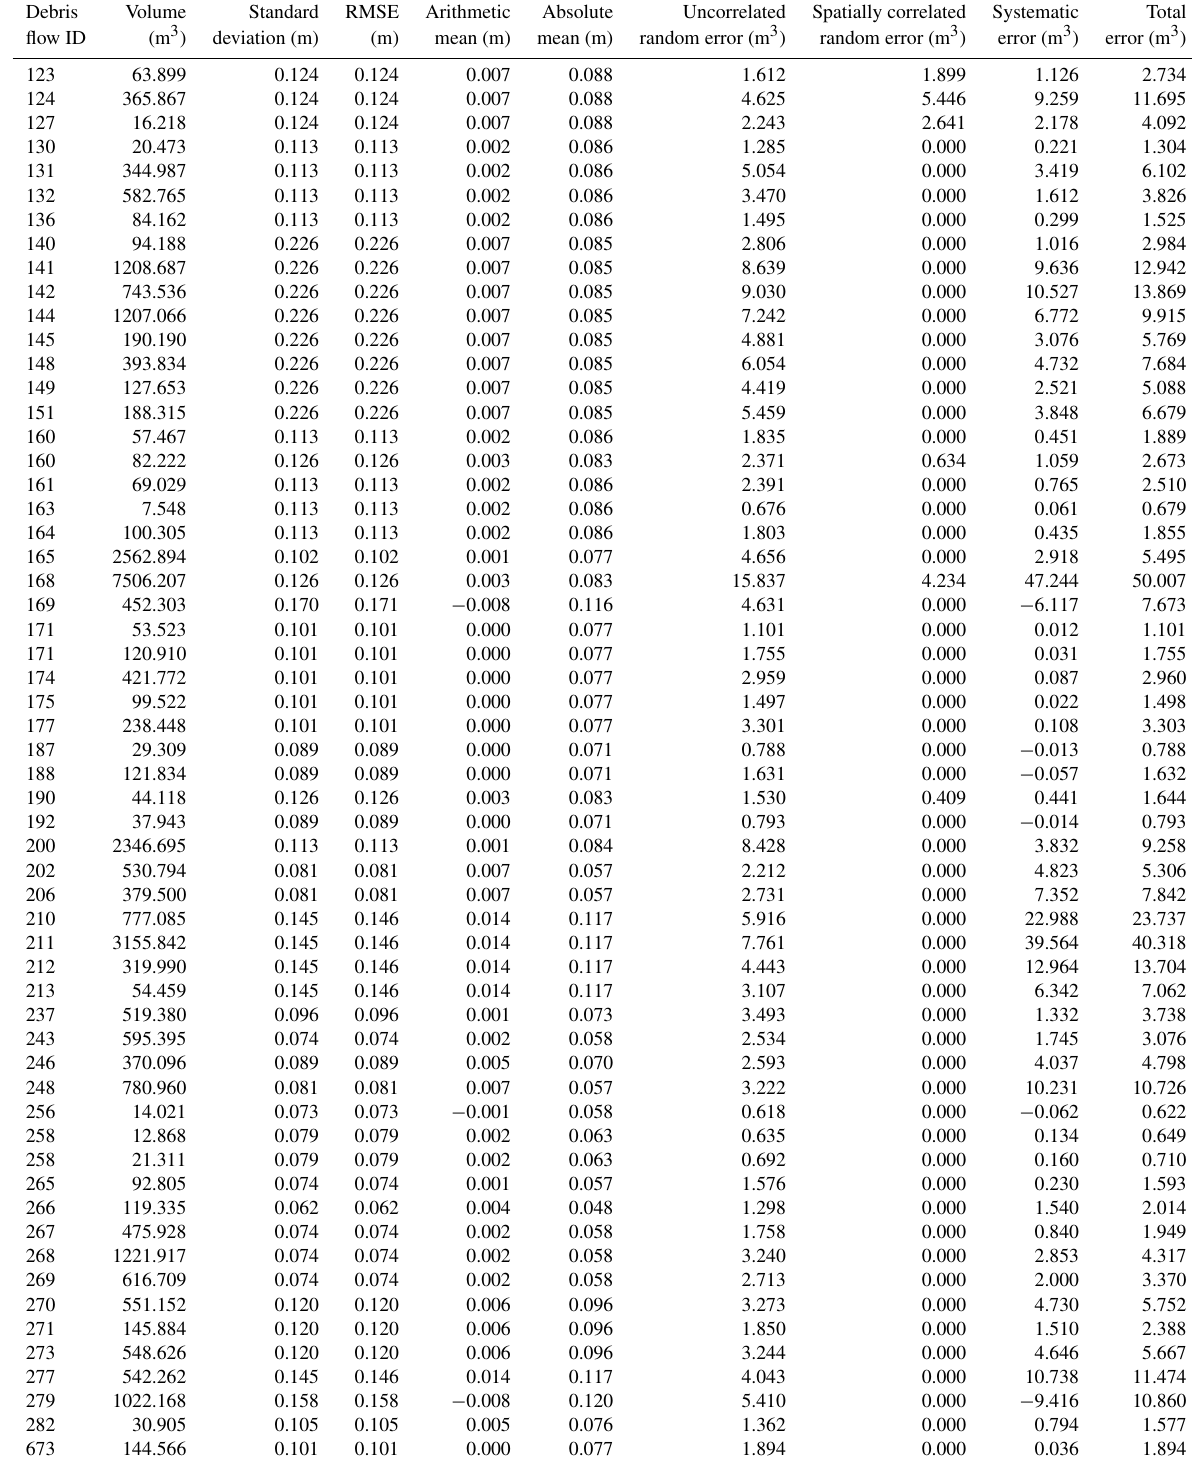
Table A1. Error assessment of debris flow deposit volumes between 2006 and 2019 following Anderson